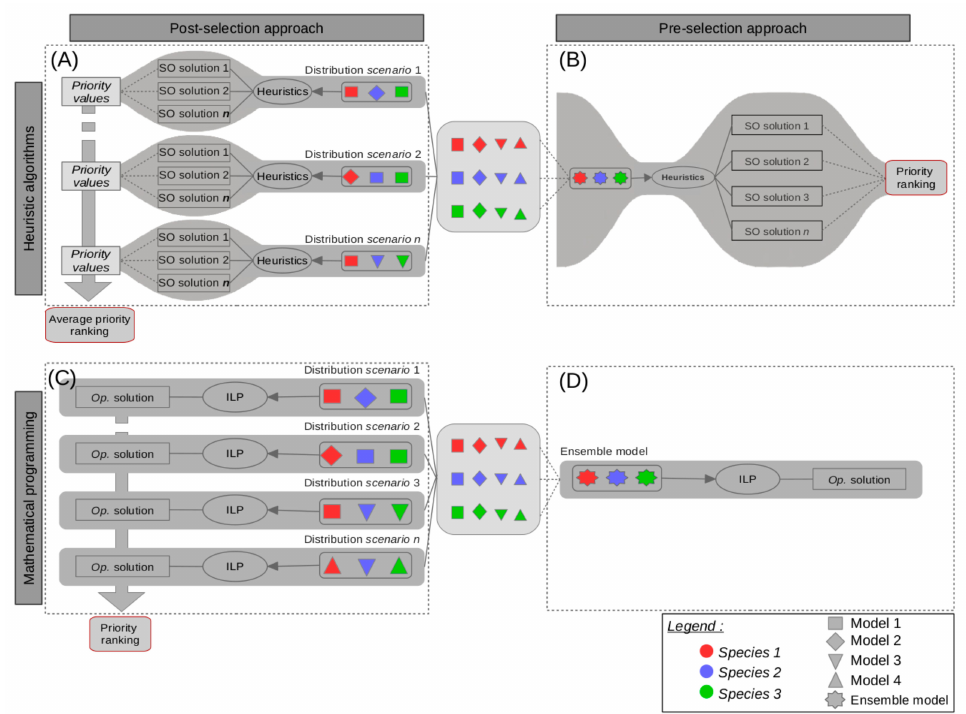
Figure 1. Schematic representation of the different approaches for the definition of spatial priorities when accounting for species distribution model uncertainties. For each species (represented by different colors), the spatial distribution is modeled using various statistical methods (each repre- sented by a different shape), from this pool of species/method predictions (central gray squares), four approaches are possible. The first two approaches use random-based heuristics, to identify conservation solutions. ( A ) A post-selection approach, where a set of sub-optimal solutions are generated for different distribution scenarios, each constructed by selecting randomly a model among all SDMs for each species. Priority rankings corresponding to different distribution scenarios are then summarized by averaging. ( B ) A pre-selection approach, where species distribution models are summarized into a unique ensemble model before reserve selection. The priority ranking is estimated from several sub-optimal solutions. The two latter approaches use exact